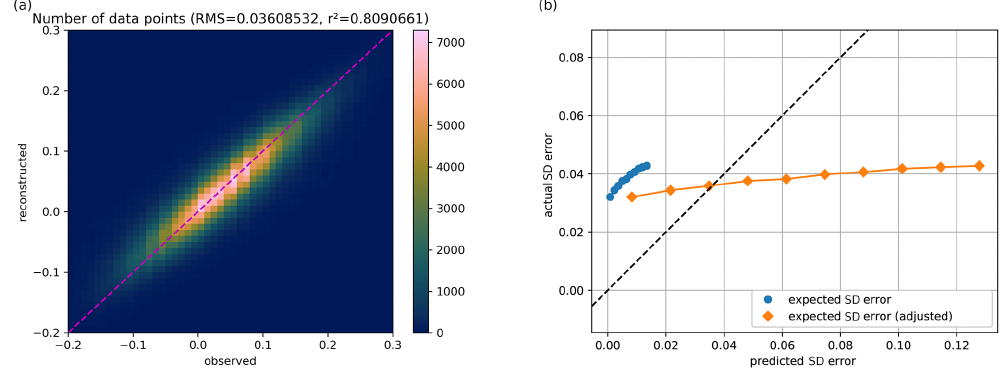
Figure 9. (a) Altimetry observation from the test data versus the reconstructed values from DIVAnd (using only the training data). (b) Expected standard deviation of the reconstruction (before and after adjustment) relative to the actual standard deviation of the reconstructed misfit. The x and y axes of both plots are expressed in meters.